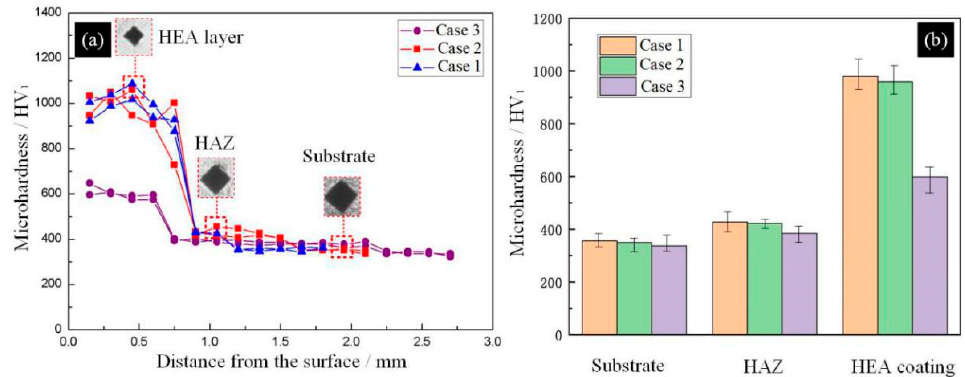
Figure 9. ( a ) Hardness depth profile in the transverse cross-section of the laser cladded coating, and ( b ) average microhardness on the cross-section of samples under different specific energy.